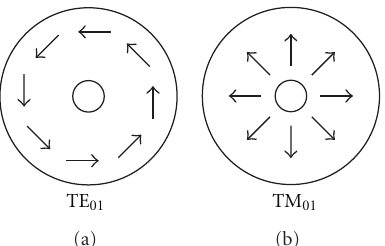
Figure 20: The lowest-order vector LG beams. (a) Azimuthally (TE 01 ) and (b) radially (TM 01 ) polarized, respectively. The arrows indicate the direction of the temporal electric field.